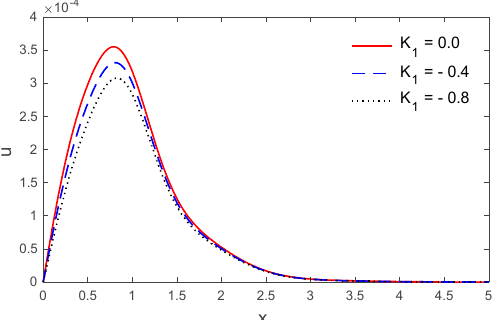
Figure 3. Variations of carrier density with respect to the distance for various values of K 1 .